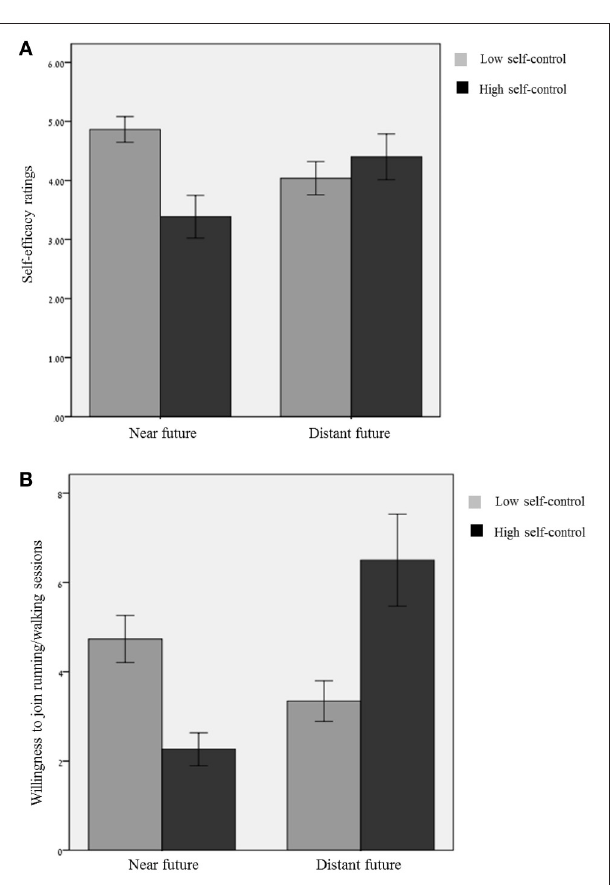
FIGURE 3 | (A) Effect of task timing on self-efficacy as a function of self-control levels. (B) Effect of task timing on willingness to join a running/walking group as a function of self-control